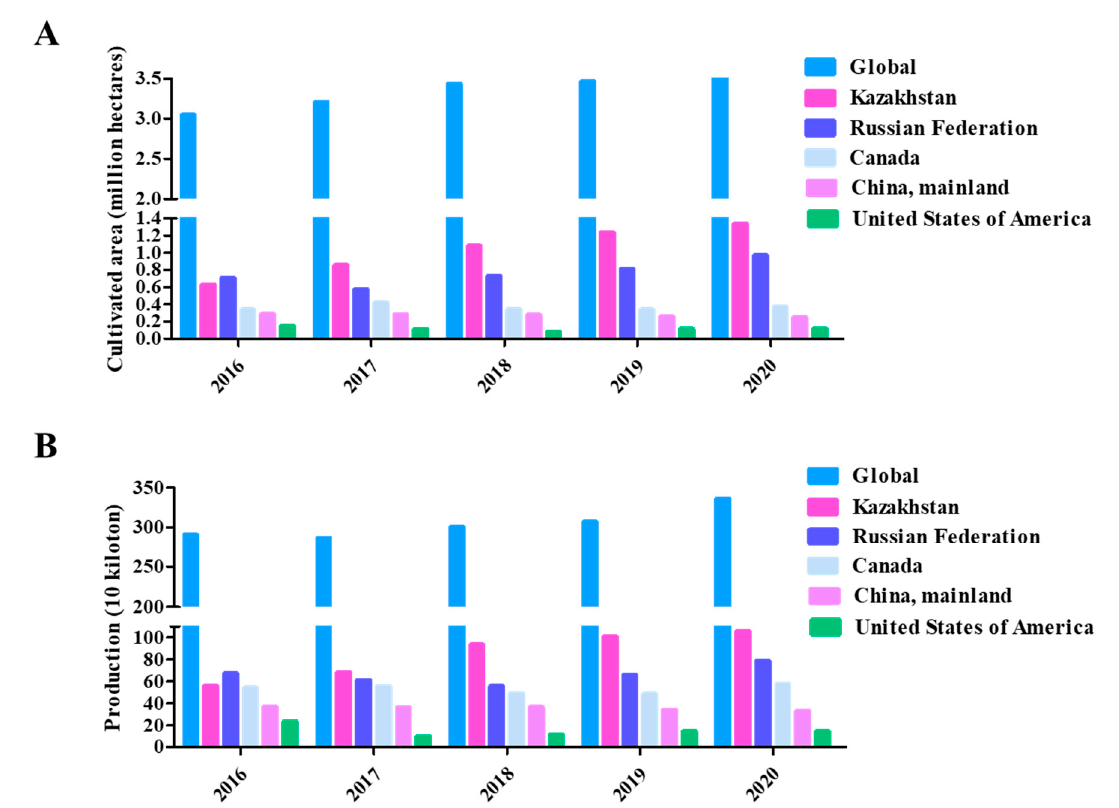
Figure 1. Flaxseed cultivated area ( A ) and production ( B ) from 2016–2020 of the top 5 countries globally (data obtained from the FAOSTAT, https://www.fao.org/faostat/en/#data/QCL, accessed on 21 November 2022).